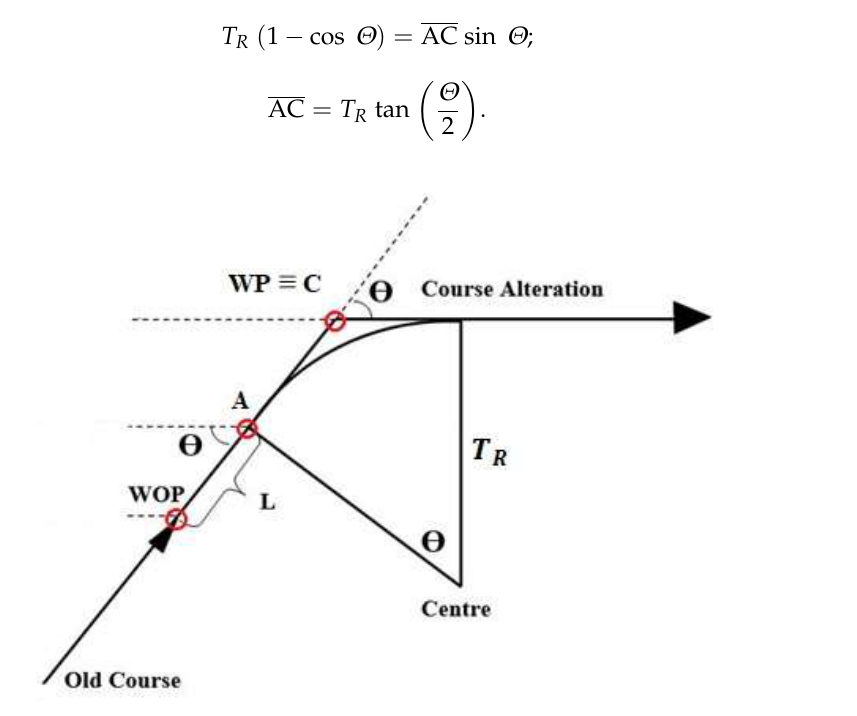
Figure 5. Manoeuvring scheme in the Venetian Canal.